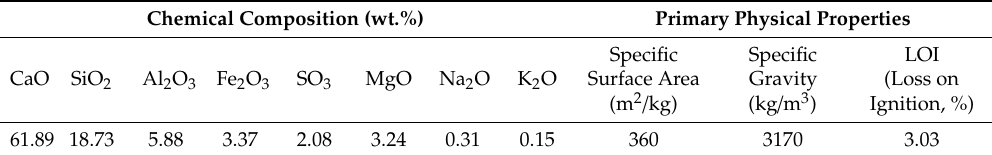
Table 1. Chemical composition and physical properties of the cement.